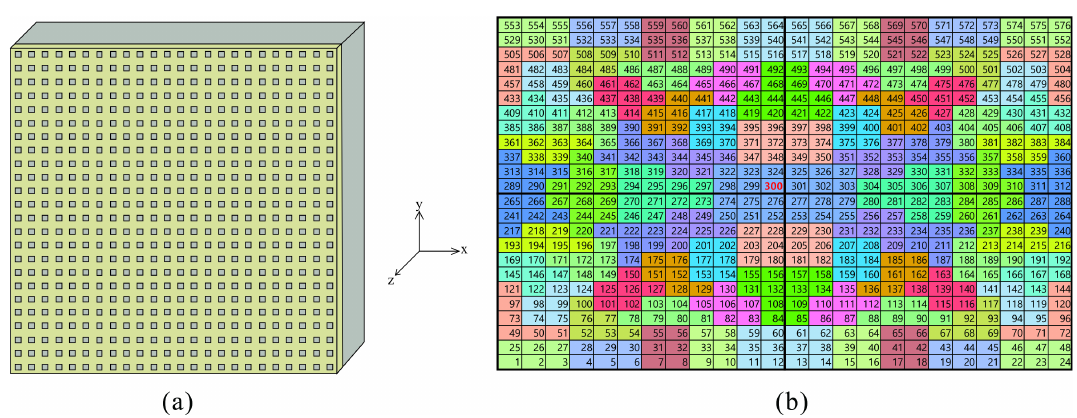
Figure 10. A 24 × 24 rectangular lattice array antenna: ( a ) cavity-type array antenna structure, ( b ) port definition from a front view ( z